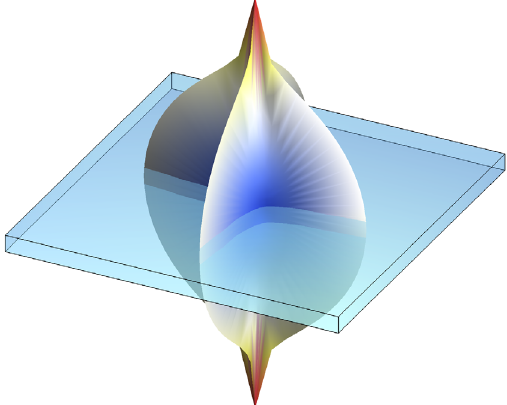
˜ R ˜ R 10 3 and x ¼ y ¼